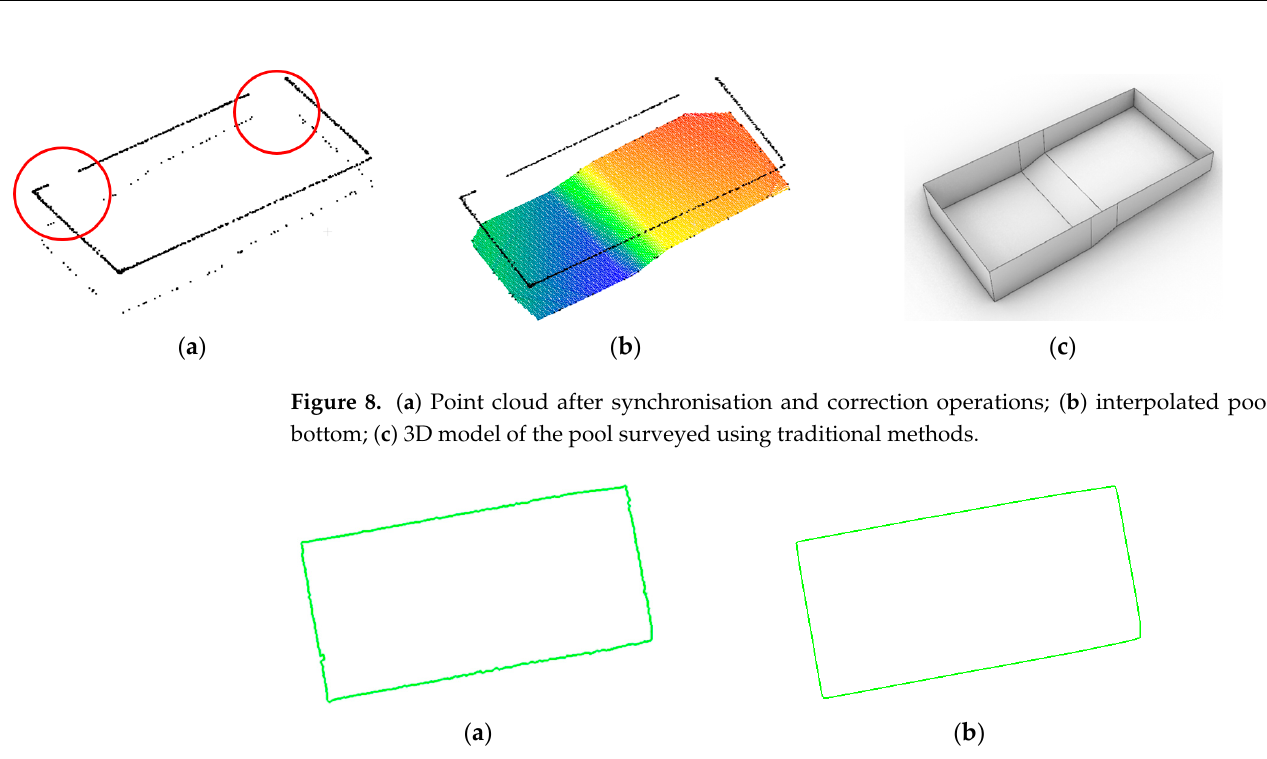
(Figure 10a). Finally, based on the primitives, the 3D model was created by the commands: Intersect, Meshpolyline and Loft (Figure 10b). Figure 9. ( a ) Pool edge contour line before regularization; ( b ) pool edge contour line after regulari-